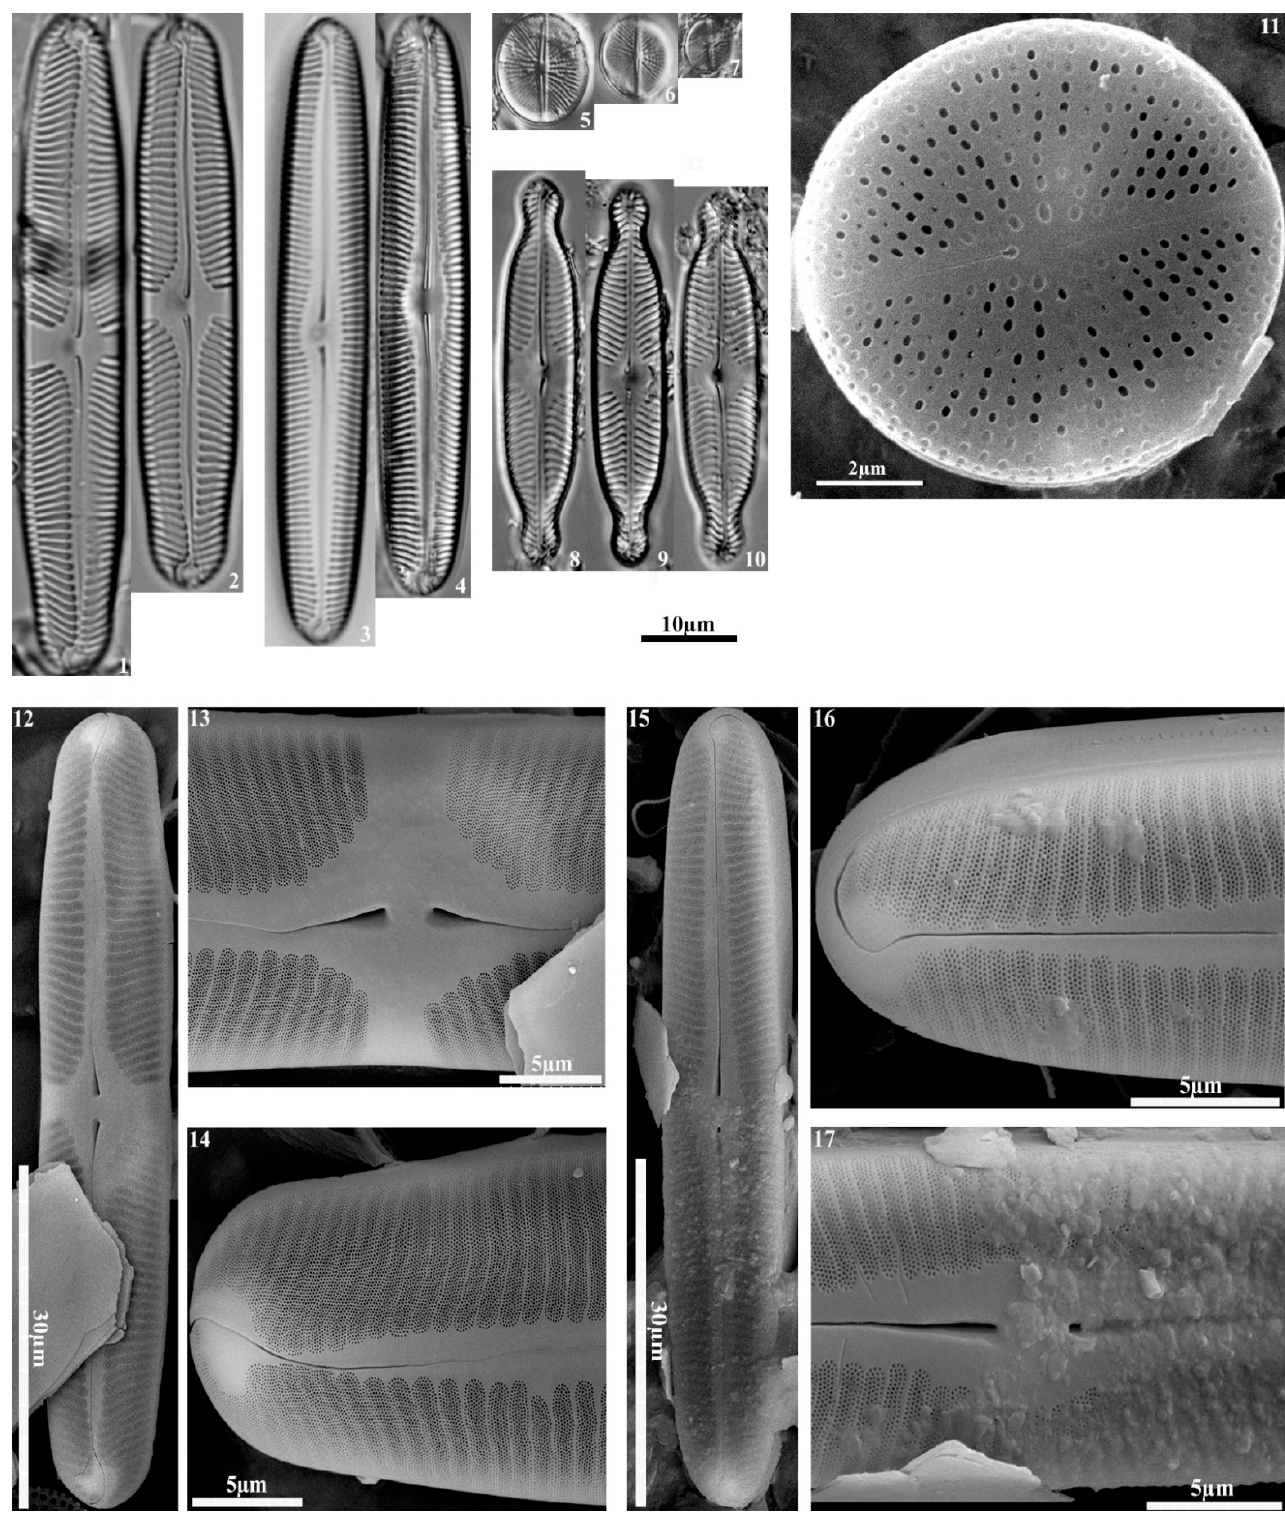
Figure 4. Regionally rare diatom species from the Nesamovyte Lake: 1–2, 12–14— Pinnularia rhombarea, 3–4, 15–17— P. rupestris , 5–7, 11— Cavinula pseudoscutiformis, 8–10— P. subanglica.